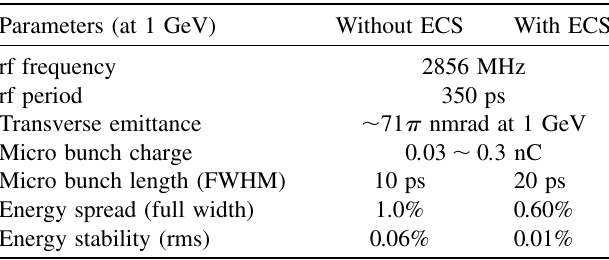
TABLE 2. Main parameters of the SPring-8 linac .